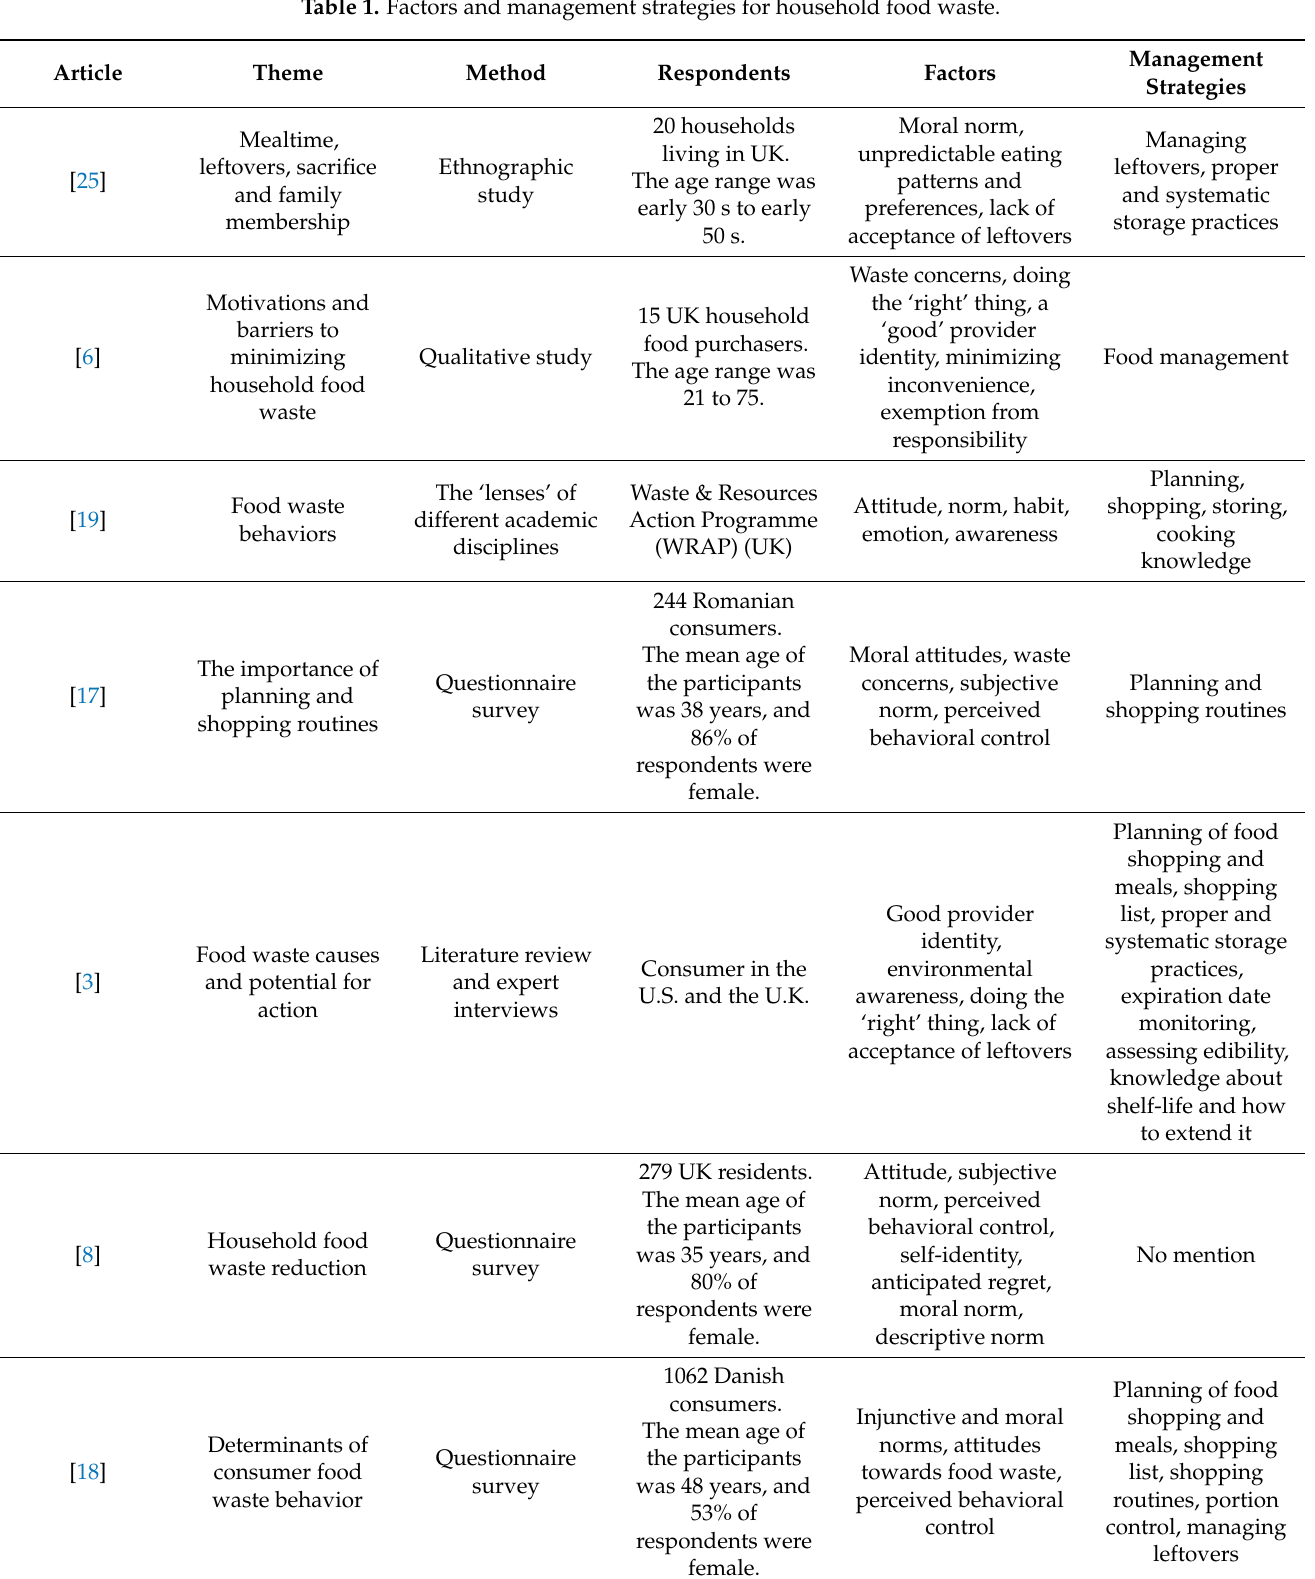
Table 1. Factors and management strategies for household food